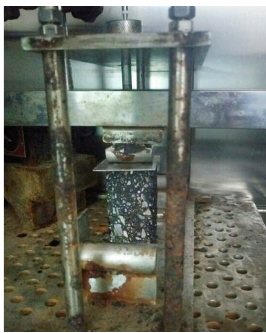
Figure 5. Loading device for creep